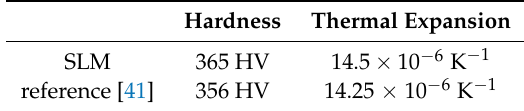
Table 4. Vickers hardness and thermal expansion coefficient of SLM fabricated CoCrW